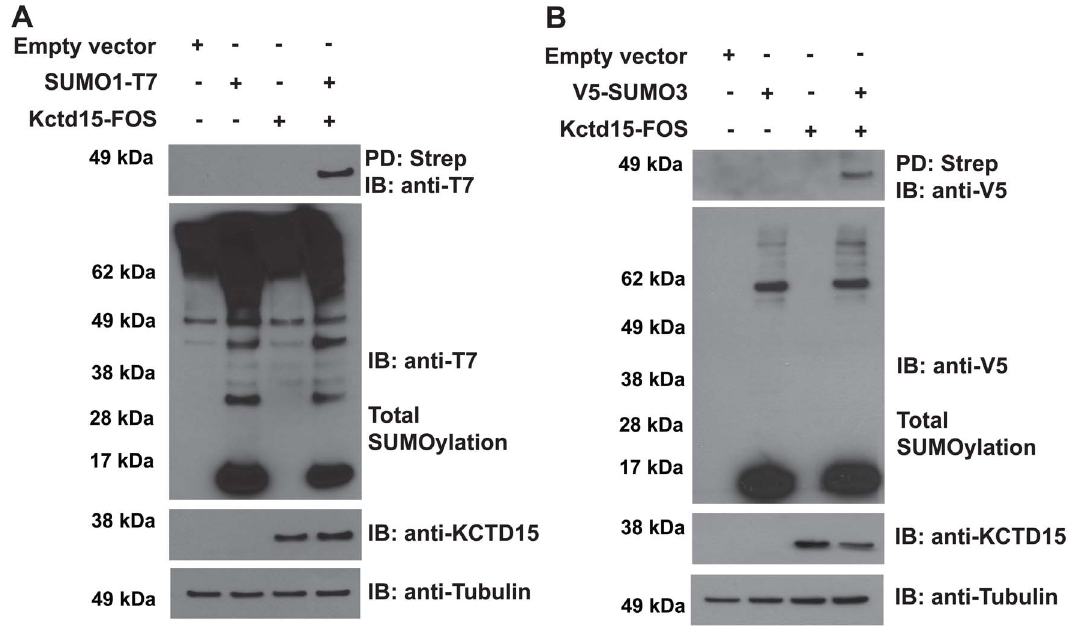
Figure 2. Kctd15 is a target for SUMOylation. (A) HEK293T cells were transfected with SUMO1-T7 with or without Kctd15-Flag-ONE-Strep (Kctd15-FOS). Cells were lysed in the presence of IAA and NEM to inhibit isopeptidase activity. Strep-Tactin pull down (PD) and immunoblotting (IB) are indicated; Tubulin was used as loading control. Immunoprecipitated Kctd15-FOS SUMOylated by SUMO1-T7 is observed in lane 4, upper panel, and total SUMOylation is shown in the second panel. (B) The same experimental approach as in (A), but using V5-SUMO3. Kctd15-FOS is SUMOylated by V5-SUMO3 (upper panel, lane 4).